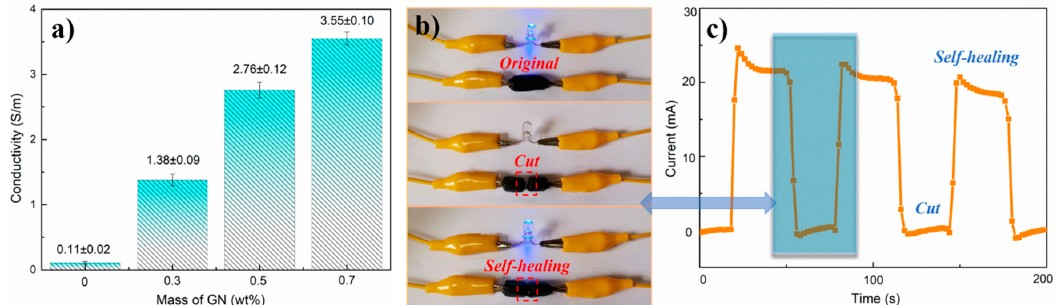
Figure 7. ( a ) Conductivity variation of GN-CNF@PVA gels with various amount of GN; ( b ) self-healing ability of conducting network in GN-CNF@PVA hydrogel when connected into a circuit; ( c ) current changes of the GN-CNF@PVA-B hydrogel during multiple cutting/healing cycles.